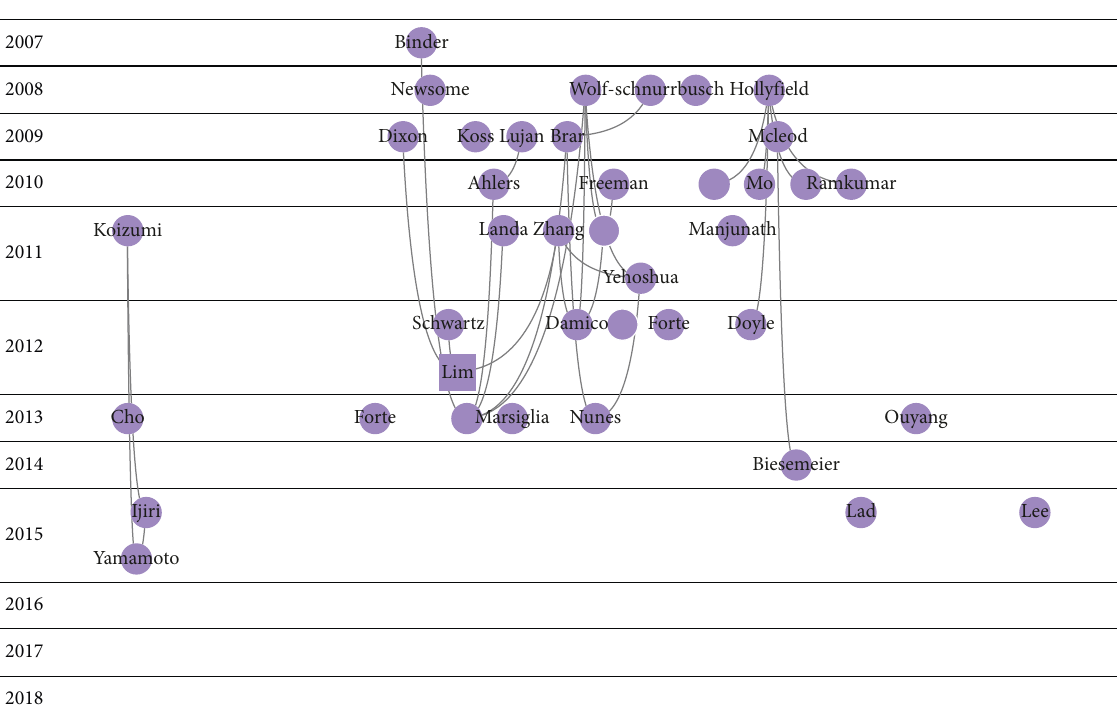
Figure 4: Citation network of cluster